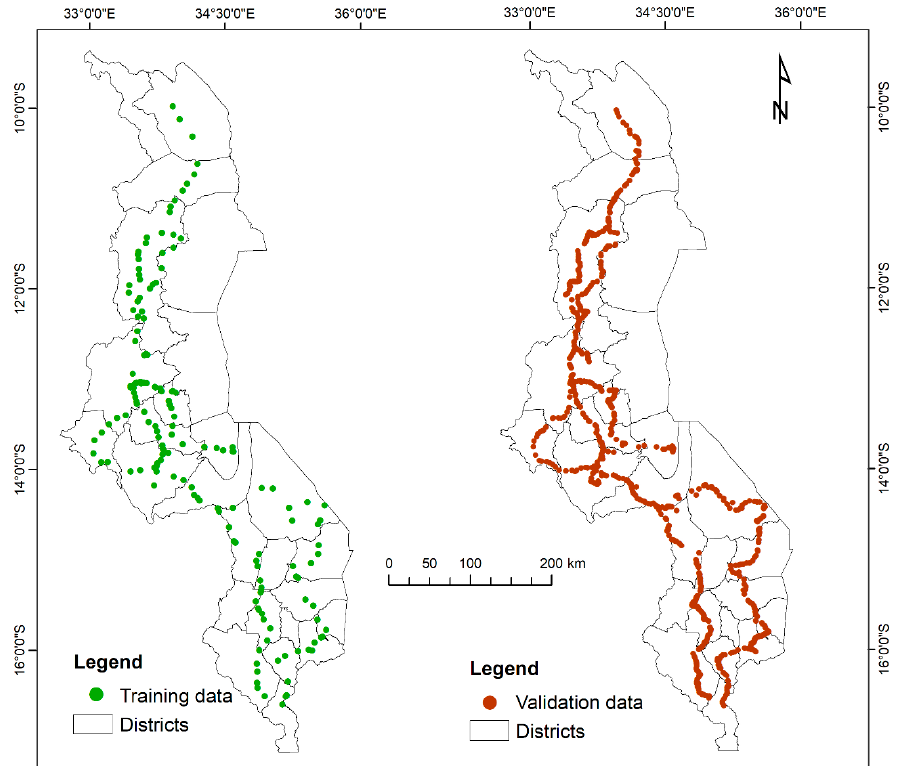
Figure 2. The distribution of ground survey data locations in the study area. The precise location of the 250 m × 250 m spread across the study area are shown on a Malawi district boundary (4200 km).